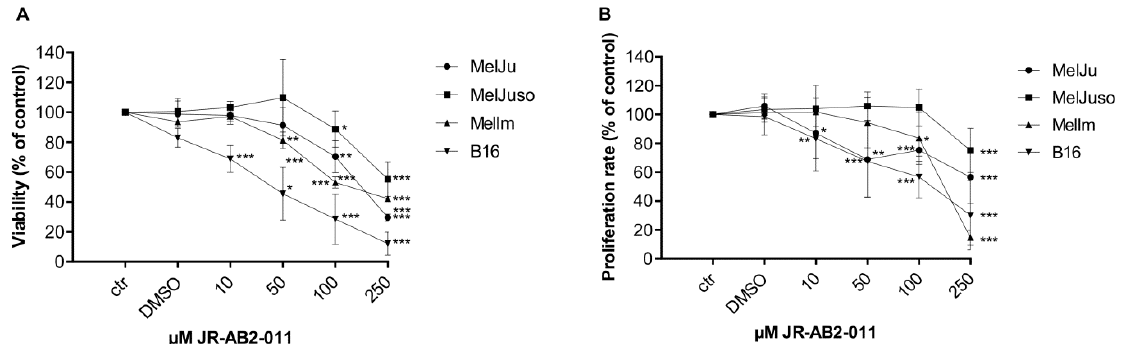
Figure 1. Inhibition of mTORC2 reduced cell viability and proliferation dose-dependently. ( A ) The dose-dependent toxic effect of JR-AB2-011 (10–250 µ M) was assessed by 3-(4,5-Dimethylthiazol-2-yl)-2,5-diphenyltetrazoliumbromid (MTT) assay over 48 h in human and murine melanoma cells. Viability was plotted relative to untreated controls set to 100% ( ± standard deviation (SD) of three independent experiments). ( B ) bromdesoxyuridin BrdU incorporation assay indicates relevant inhibition of proliferation in human and murine melanoma cells by JR-AB2-011 (10–250 µM) after 48 h compared with the loss of cells in MTT assay. Treatment was normalized to untreated controls ( ± SD of three independent experiments). Asterisks (* p ≤ 0.05, ** p ≤ 0.01, *** p ≤ 0.001) indicate significance between treatment and the control.